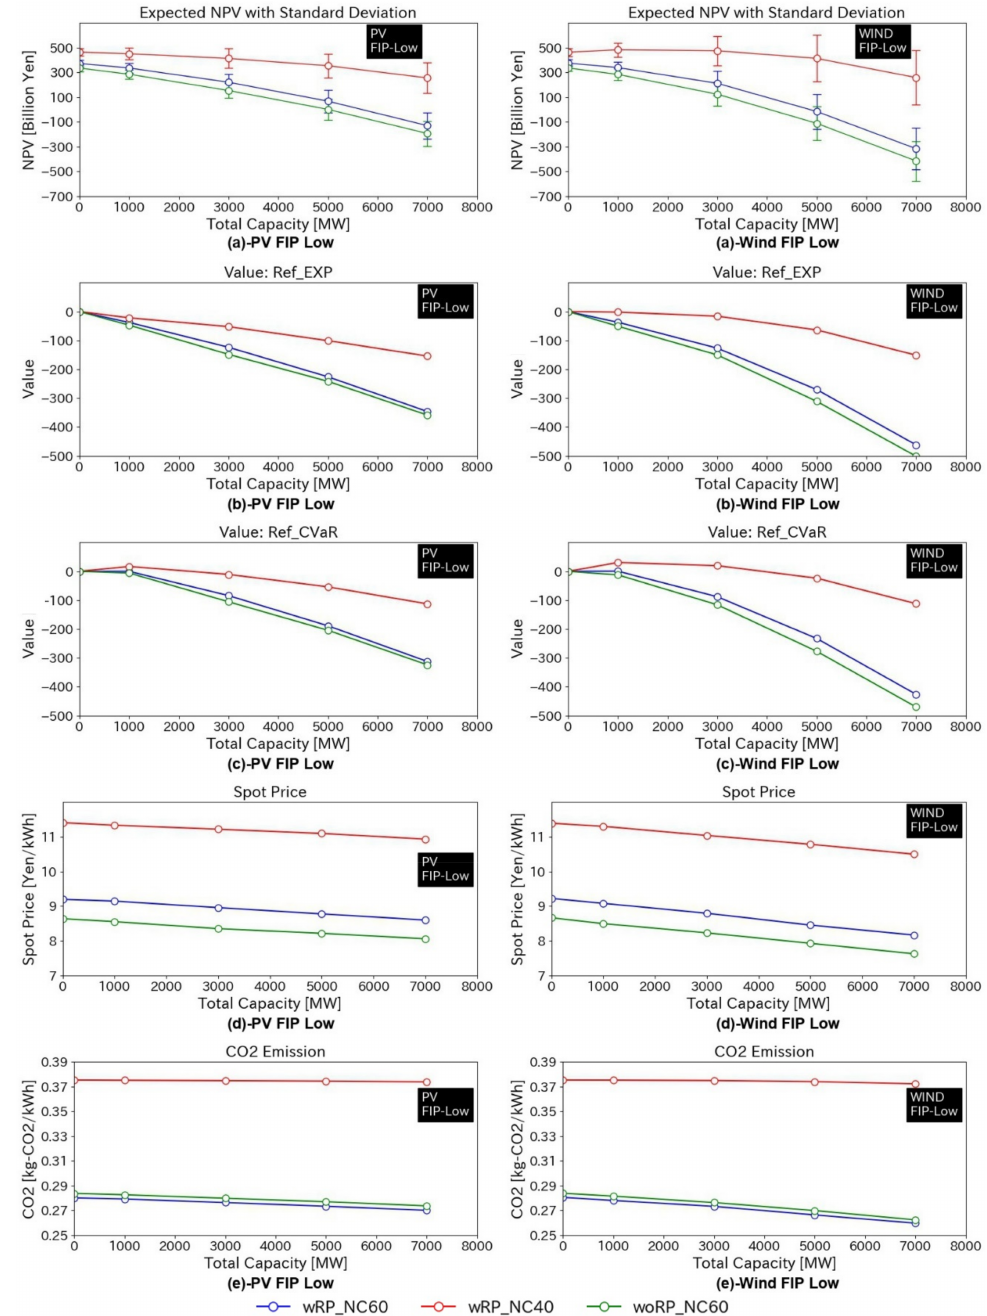
Figure 9. Results of different strategies of Company 1 with low FIP: ( a ) Expected NPV with stan- dard deviation, ( b ) Value in case of high RFP, ( c ) Value in case of low RFP, ( d ) Spot price, and ( e ) CO 2